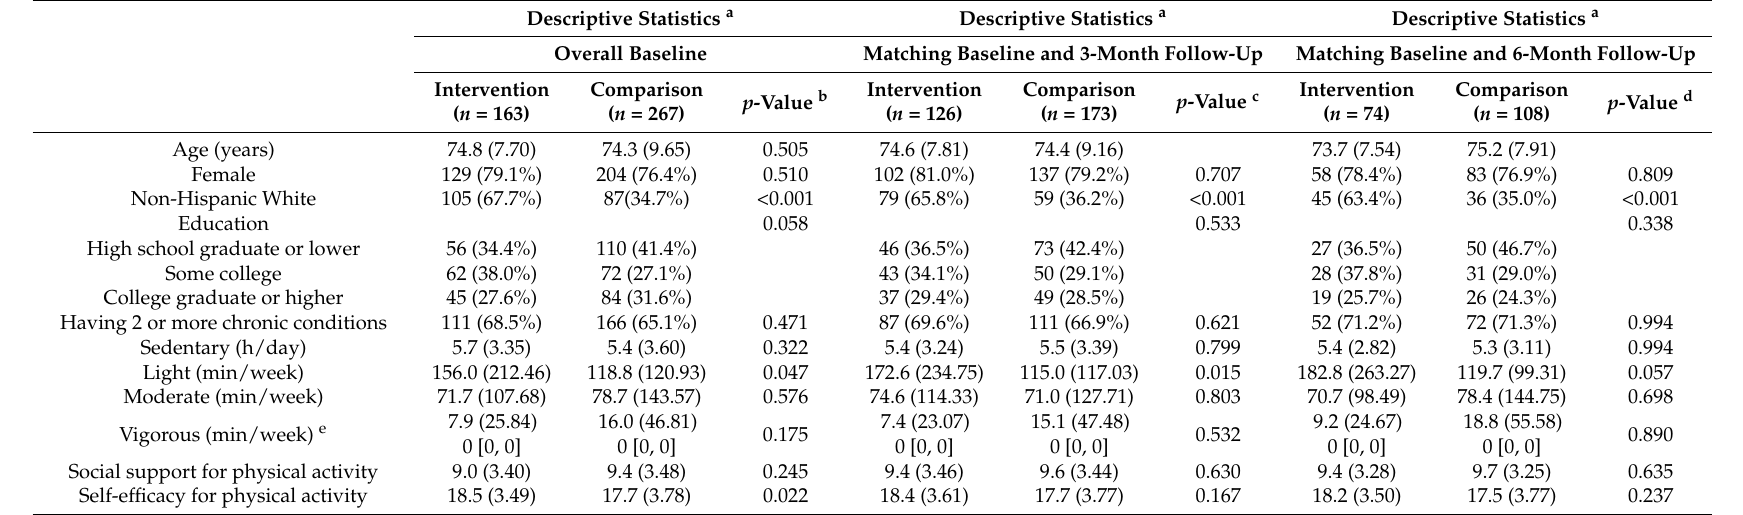
Table 1. Baseline characteristics of the study participants (Intervention vs.